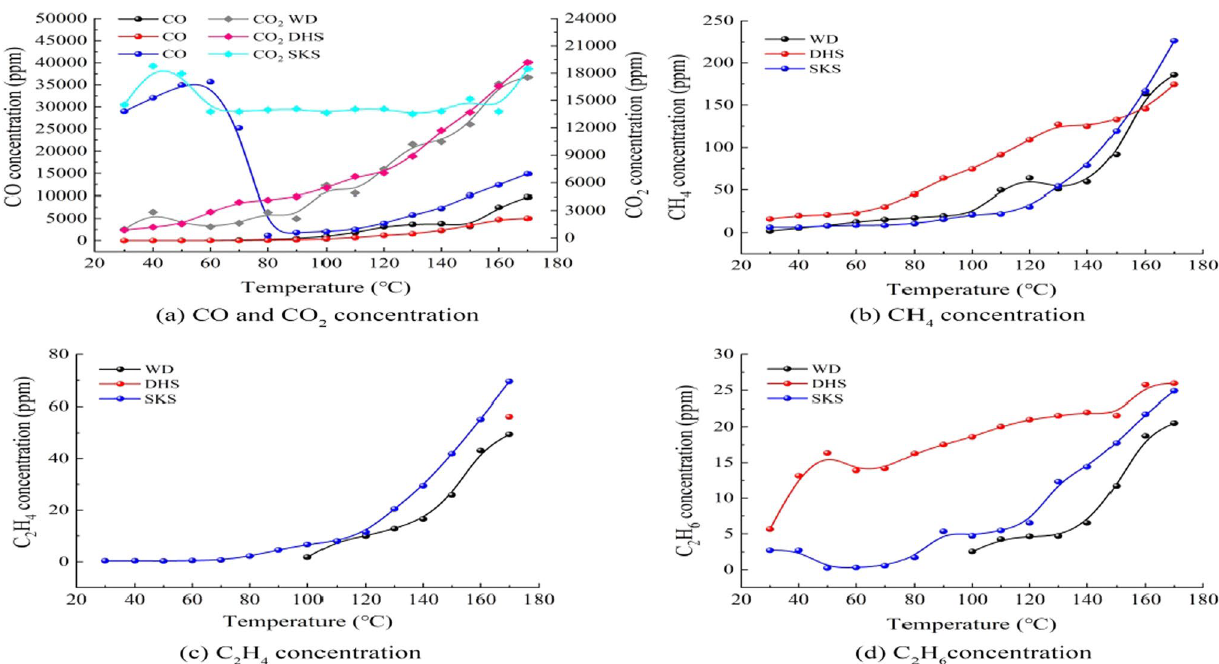
Fig. 9 Concentrations of CO and CO